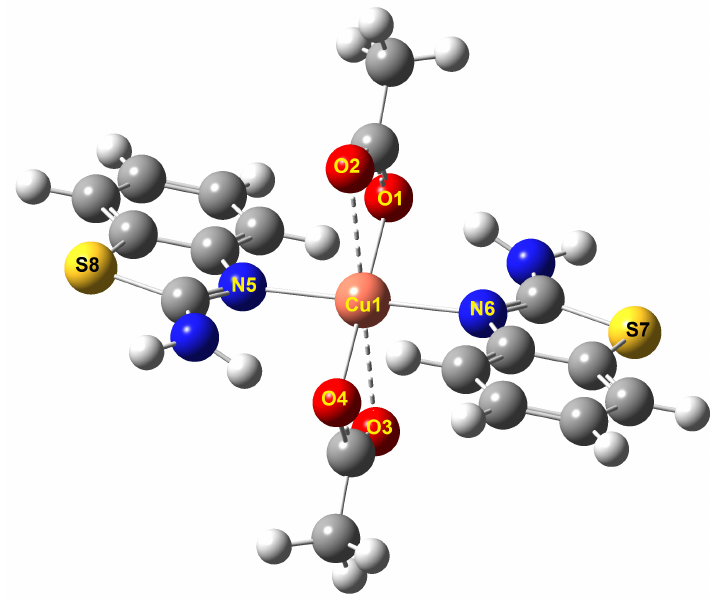
Figure 1. Optimized structures of 1 at the B3LYP / 6-31G(d,p) (LANL2DZ for Cu) level. Table 1. Some calculated and experimental structural parameters of 1 . Calculated Experimental a